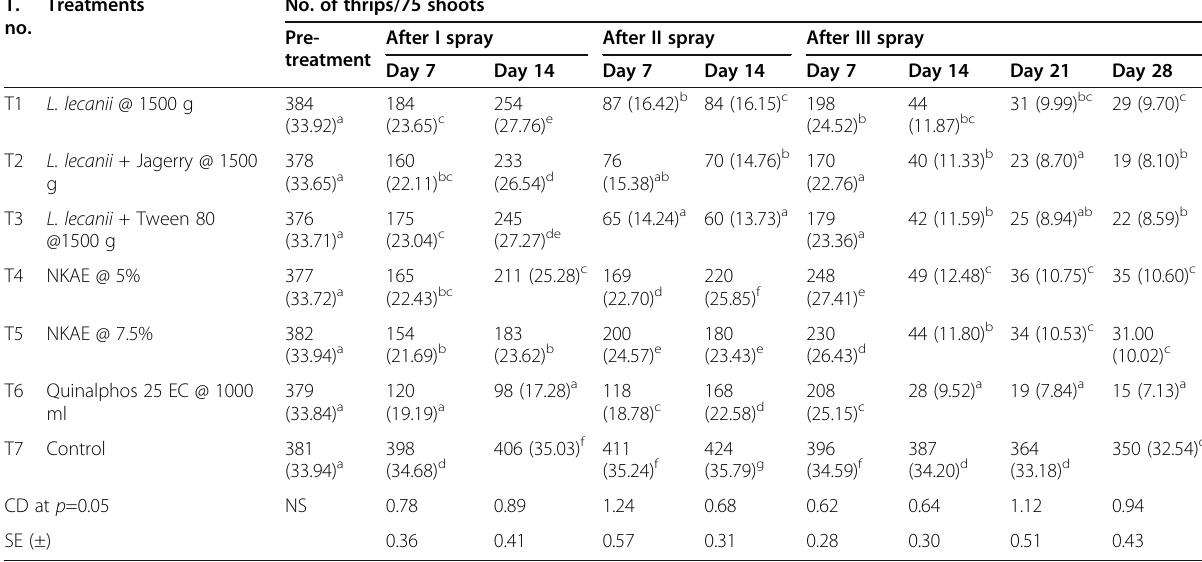
Table 5 Large scale field bio-efficacy trial (RBD) of Lecanicillium lecanii against thrips (season II) T. Treatments no.